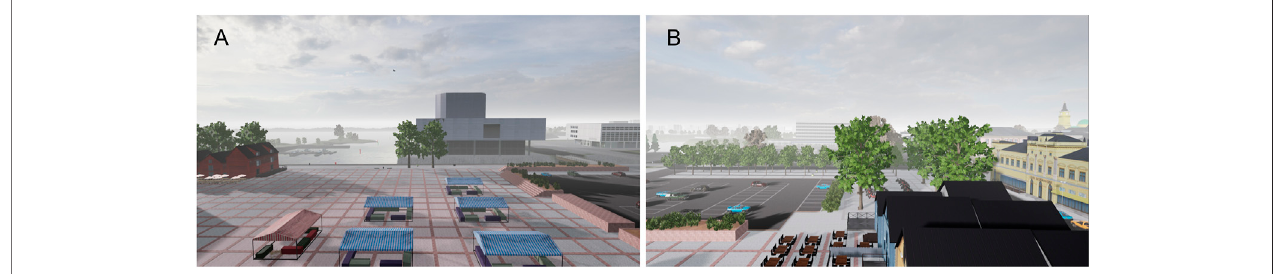
FIGURE 5 | The VE used in Study 2 as seen by subjects in the beginning of the experiment when looking forward (A) and right (B)